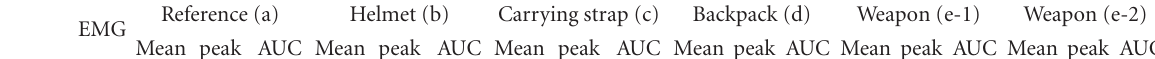
Table 2: Summary of significant e ff ects on the EMG of di ff erent